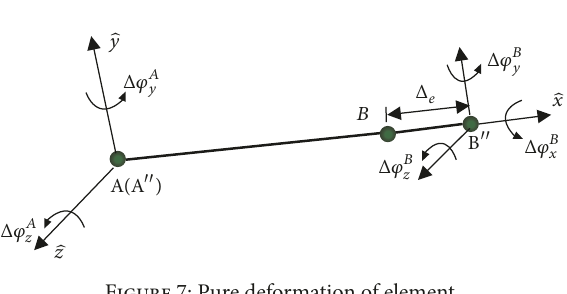
Figure 7: Pure deformation of element.